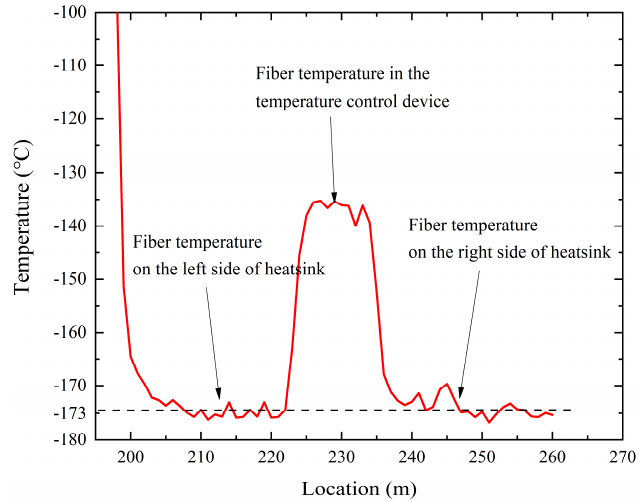
Figure 12. The temperatures along the optical fiber at given times.